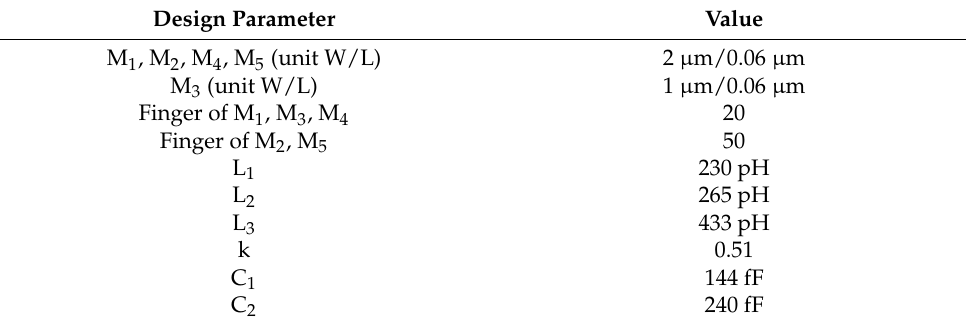
Table 1. Design parameters of the proposed